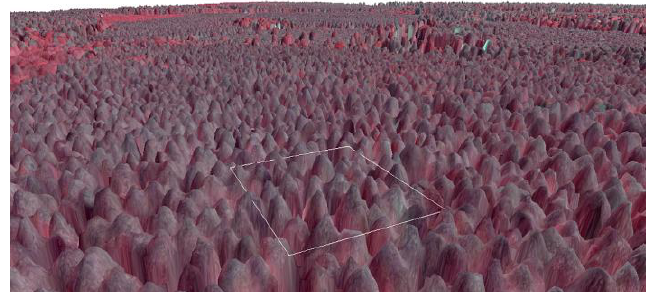
Figure 2. 3D view (DSM with CIR texture) of a typical pine stand in the study area with one of the square field plots (visualized by the white